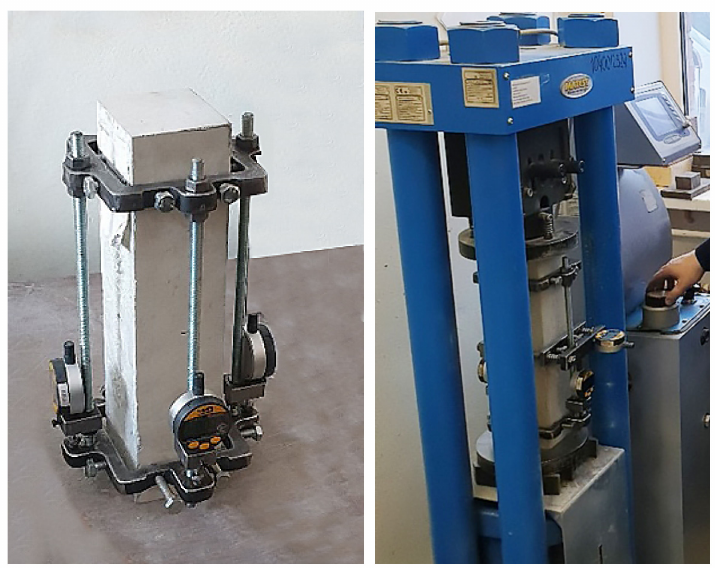
Figure 1. Concrete sample modulus of elasticity under compression